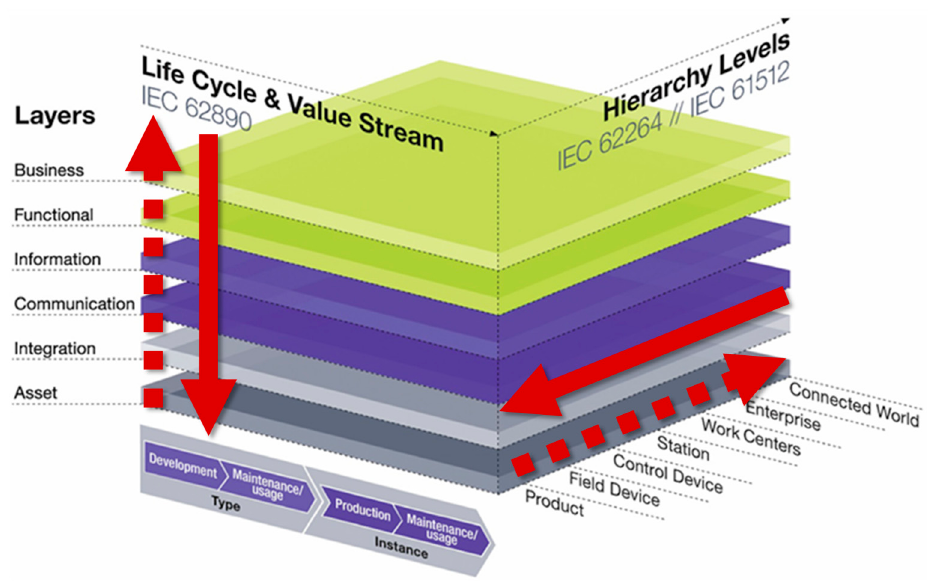
Figure 13. Industry 4.0 design directions in RAMI4.0 (adopted from [15]; this figure © Plattform Industrie 4.0 & ZVEI—Zentralverband Elektrotechnik—und Elektronik-industrie e.V.).